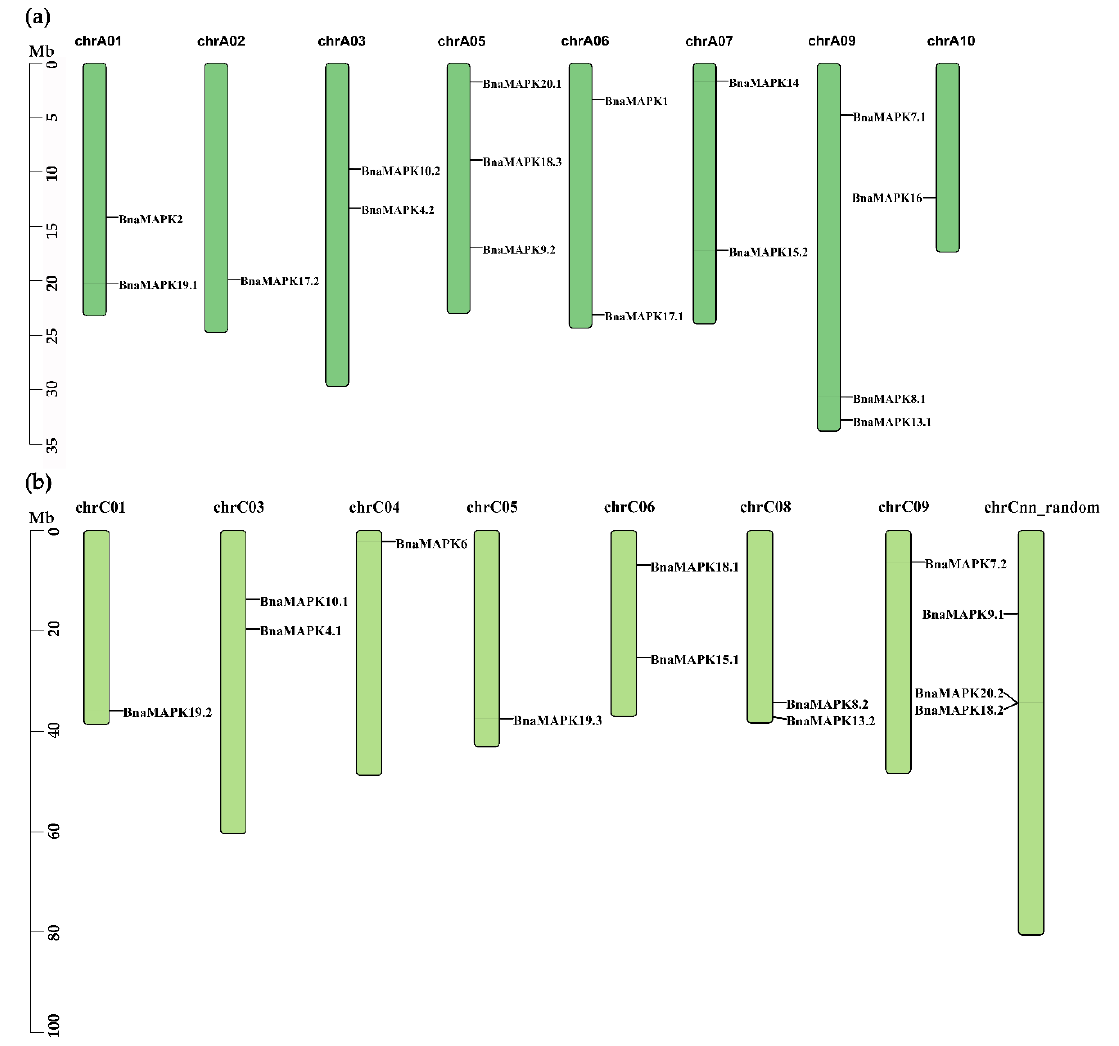
Figure 3. Chromosomal locations of BnaMAPK genes in B. napus genome. ( a ) Genomic position of BnaMAPK genes in subgenome A. ( b ) Genomic position of BnaMAPK genes in subgenome C.